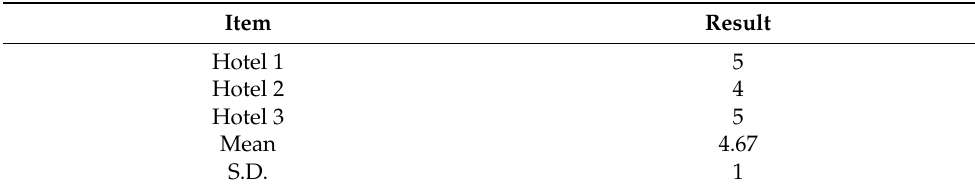
Table 10. How would you assess the level of cohesion and teamwork of the staff? From 1 (very low) to 5 (very